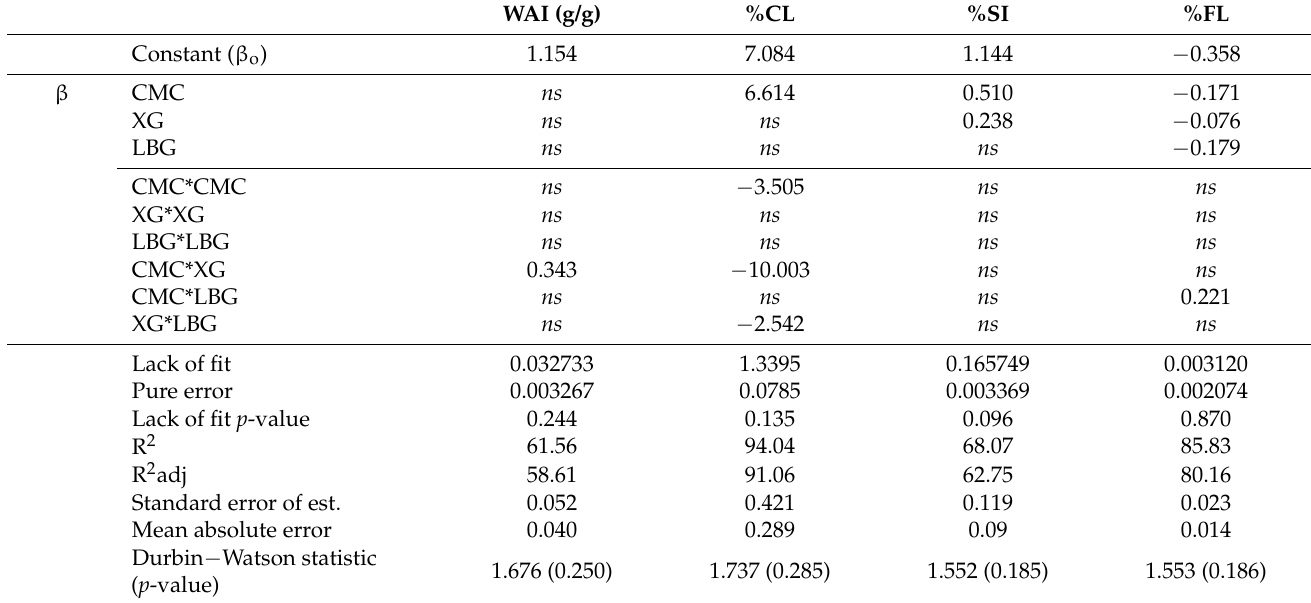
Independent variables: CMC (carboximethylcelullose); XG (xanthan gum); LBG (locust bean gum). Subscripts o and c refer to the uncooked and cooked pasta samples, respectively. Only significant relations are shown. Analysis of variance at the 95% confidence level. ns , no significant effect at level <